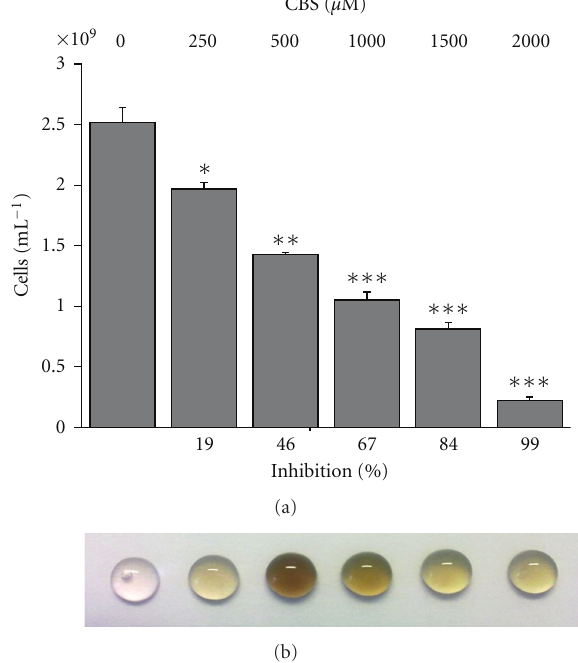
Figure 1: Growth inhibition of B. thetaiotaomicron 48h cultivation after addition of CBS ( n = 3). The addition of CBS to the growing B. thetaiotaomicron cultures (a) resulted in an inhibition of the maximal cell density in the stationary phase at 48h after the addition of CBS in a concentration-dependent manner. Figure 1(b) shows a black precipitation in 20 µ L droplets from the